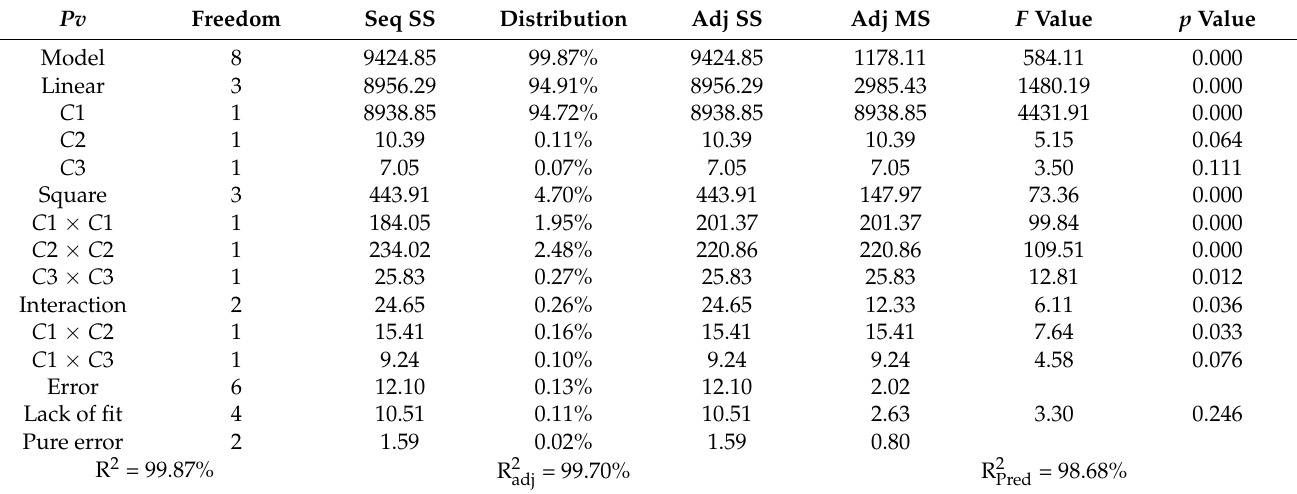
Table 3. Variance analysis of the response for Pv .